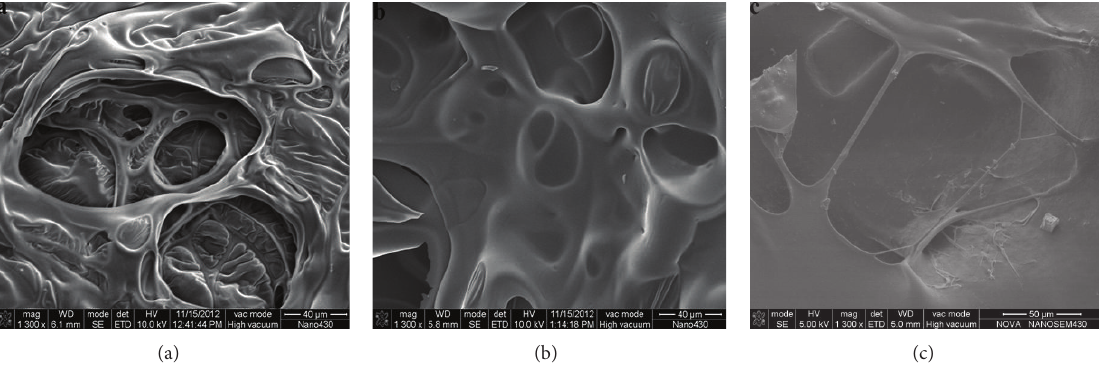
Figure 8: SEM images of char residue after cone calorimeter test: (a) neat PU, (b) DPTP (2phr), and (c) DPTP